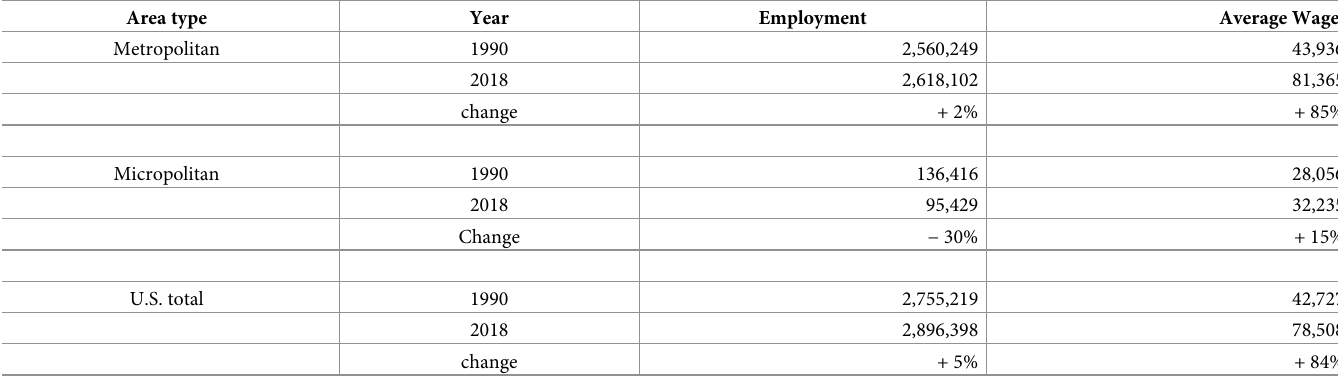
Table 1. Wage and employment changes in industry sector 51: Information Services,